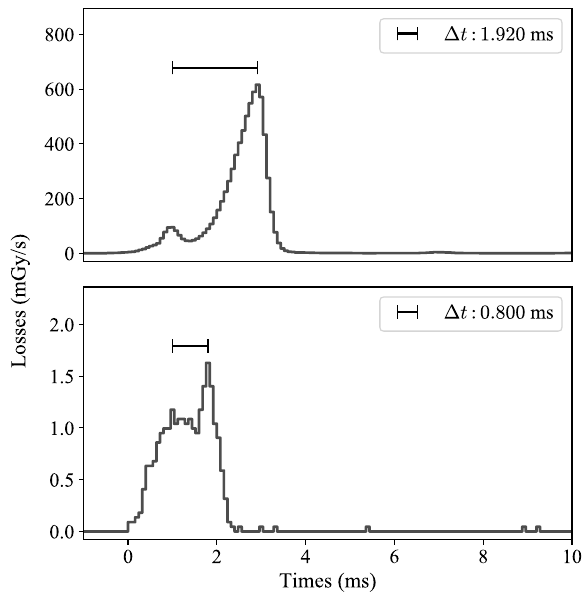
FIG. 14. Measurement of beam loss events with over- lapping multipeaks attributed to dust grains during LHC Run II. Given the response factor of the beam loss monitors, the amplitude of the losses is in the order of 10 9 − 10 11 inelastic collisions =